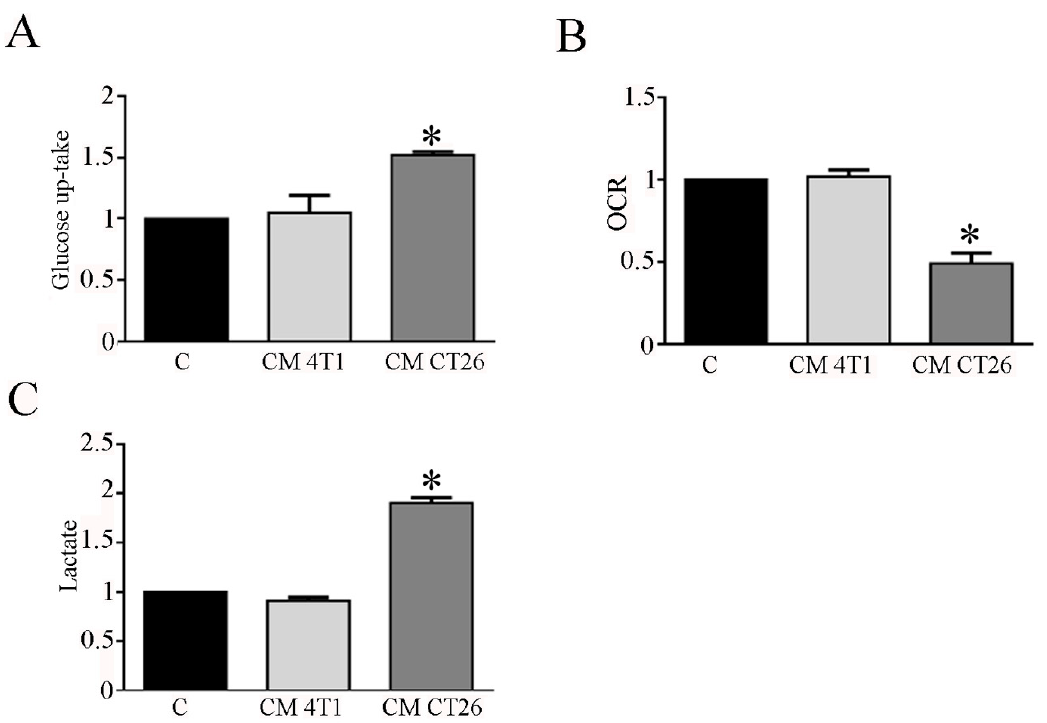
Figure 1. CM CT26 treatment modifies glucose metabolism in myotubes. Twenty-four hours after the treatment of myotubes with CMs or with differentiating medium (reported as C, control), ( A ) glucose uptake, ( B ) Oxygen Consumption Rate (OCR), and ( C ) extracellular lactate amount was assayed. The values are reported as folding increase considering control myotubes as 1; n = 4; * p < 0.05.